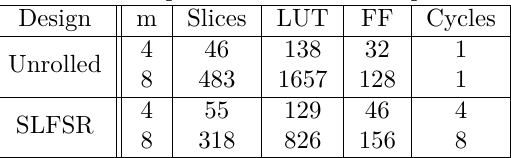
Table 1: P&R performances and comparisons